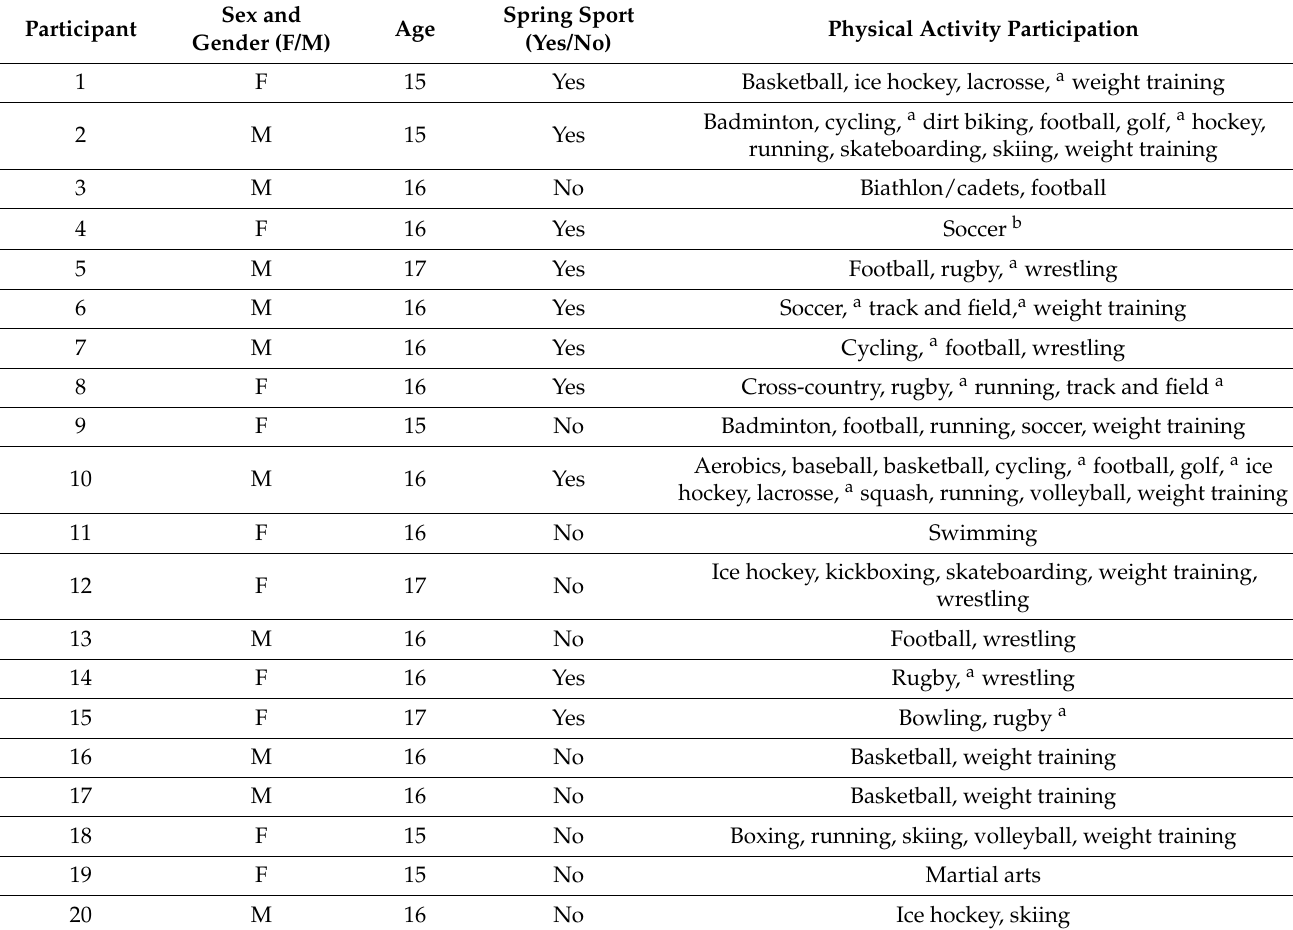
Table 1. Participant characteristics by gender/sex, age, and spring sport, and physical activity participation.